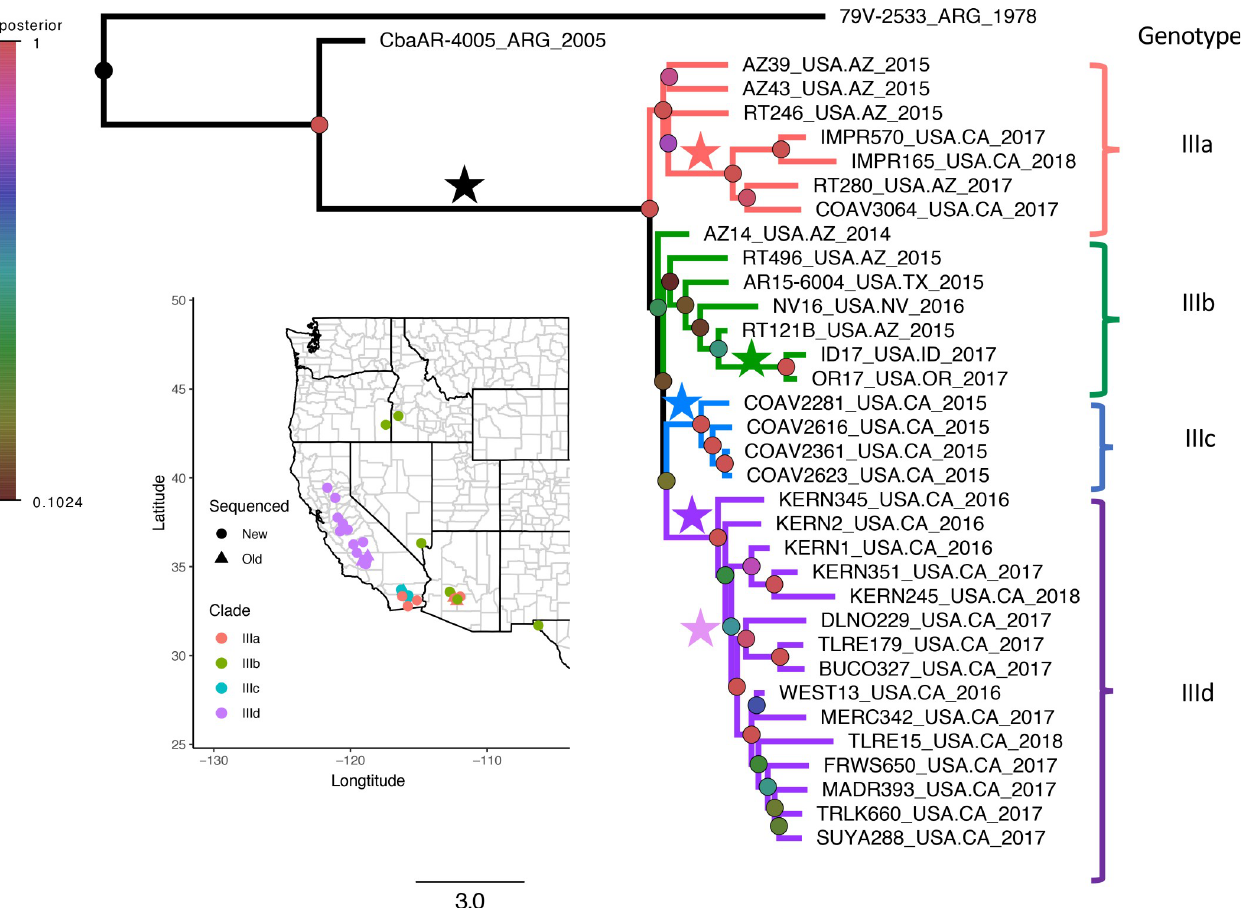
Fig 3. Bayesian phylogeographic analysis showing four distinct clusters of SLEV genotype III in the western US. The branch length is scaled to time in years and the posterior support of each node is represented by the colored circle. Branch length scale is provided at the base of the phylogeny. Colored stars to the left of clades denote shared amino acid substitutions: Black = A-261-V, G-2195-S, L-2210-S, and A-2383-V; Red = G-2288-E; Green = H1079-I and I- 2233-V; Blue = I-3095-V; Dark purple = P-2298-S and Light purple = Q-538-R. The map indicates the location of mosquito pool collections. Circles represent new genomes that were generated during this study and triangles represent old genomes sourced from GenBank. Genome names are as follows: Strain_Location_Year. Abbreviations: Argentina, ARG; Arizona, AZ; California, CA; Idaho, ID; Nevada, NV; Oregon, OR; Texas, TX.